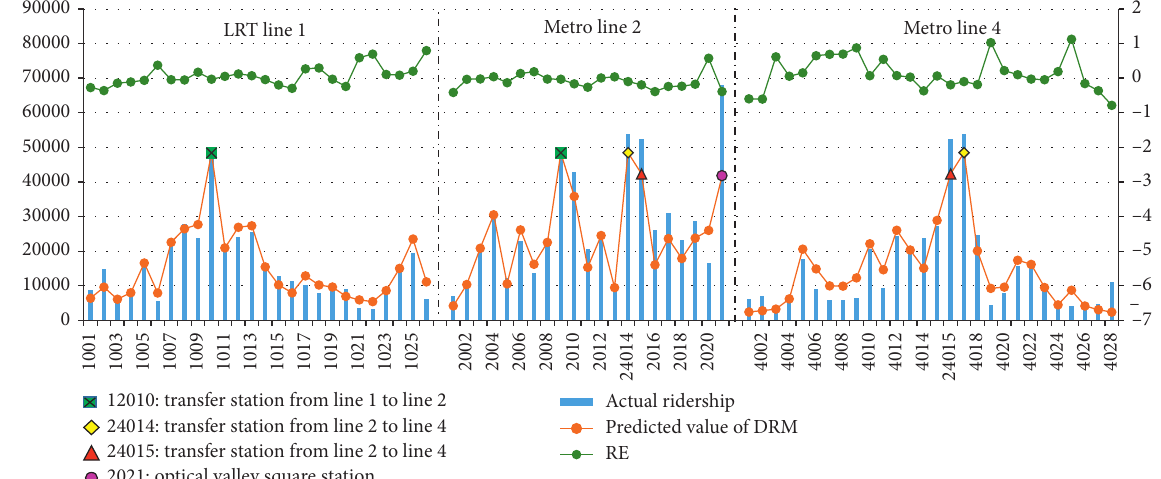
Figure 6: Predicted versus actual ridership and relative errors for MRT stations.